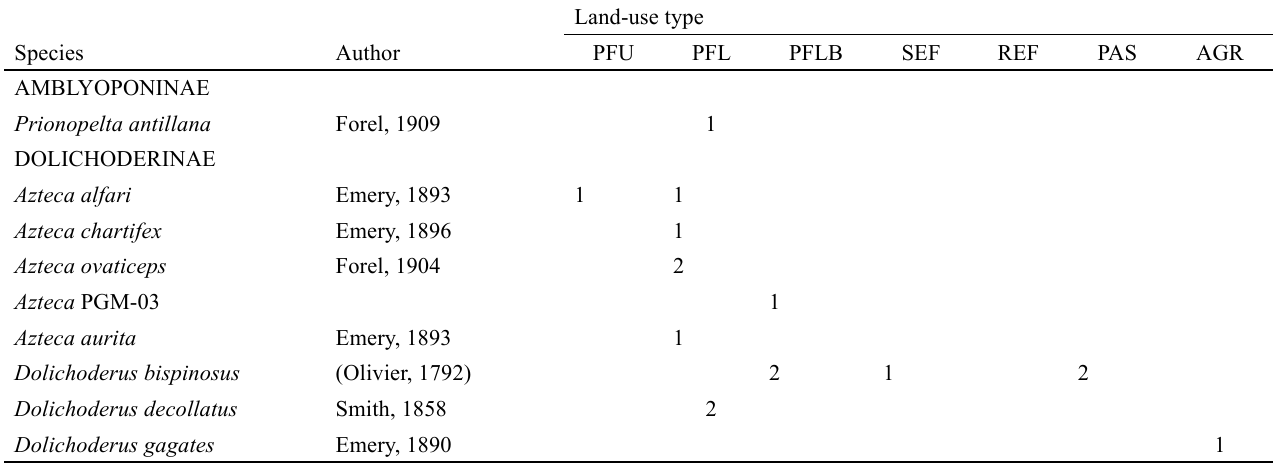
Table 2 . List of ant species collected in this study. Values represent number of records per pitfall traps of each species in each land-use type: PFU – primary forest undisturbed, PFL – primary forest logged, PFLB – primary forest logged and burnt, SEF – secondary forest, REF – reforestation with commercial species, PAS – pasture, AGR – agricultural